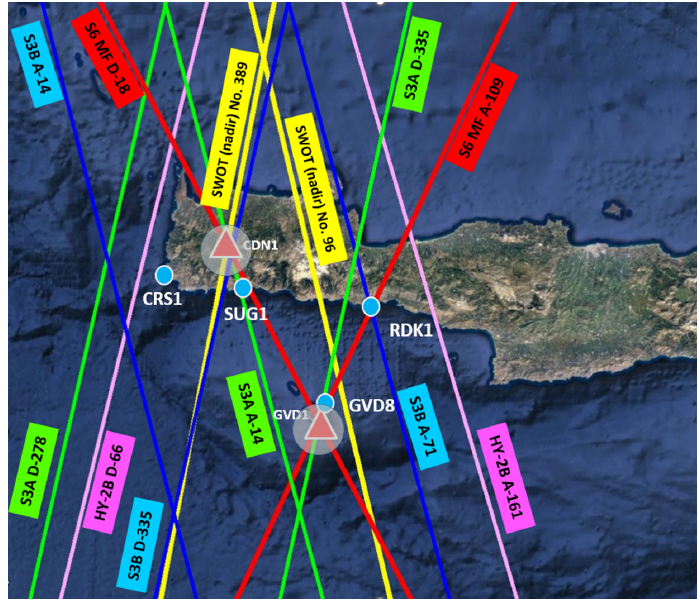
Figure 1. The PFAC network in western Crete with the ground track coverage of all operational satellite altimeters. Cal/Val sites are equipped with microwave transponders (red triangles), ra- diometer, permanent GNSS stations, tide-gauge sensors, meteorological, communications links and other